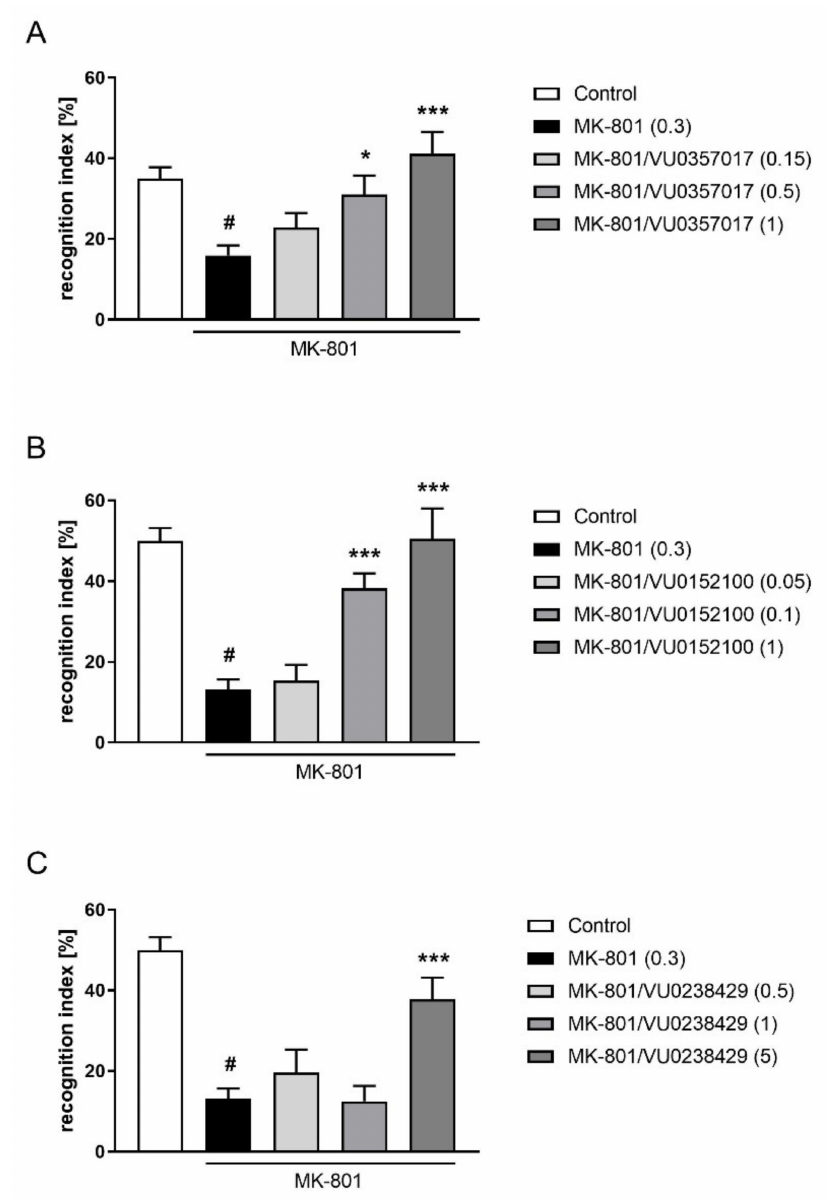
Figure 9. Activity of VU0357017 ( A ), VU0152100 ( B ), and VU0238429 ( C ) in the NOR test after seven days of administration. The data are presented as means ± SEM. Doses of the compounds are indicated in parentheses. # p < 0.001 compared to control animals and * p < 0.05, *** p < 0.001 compared to MK-801-treated